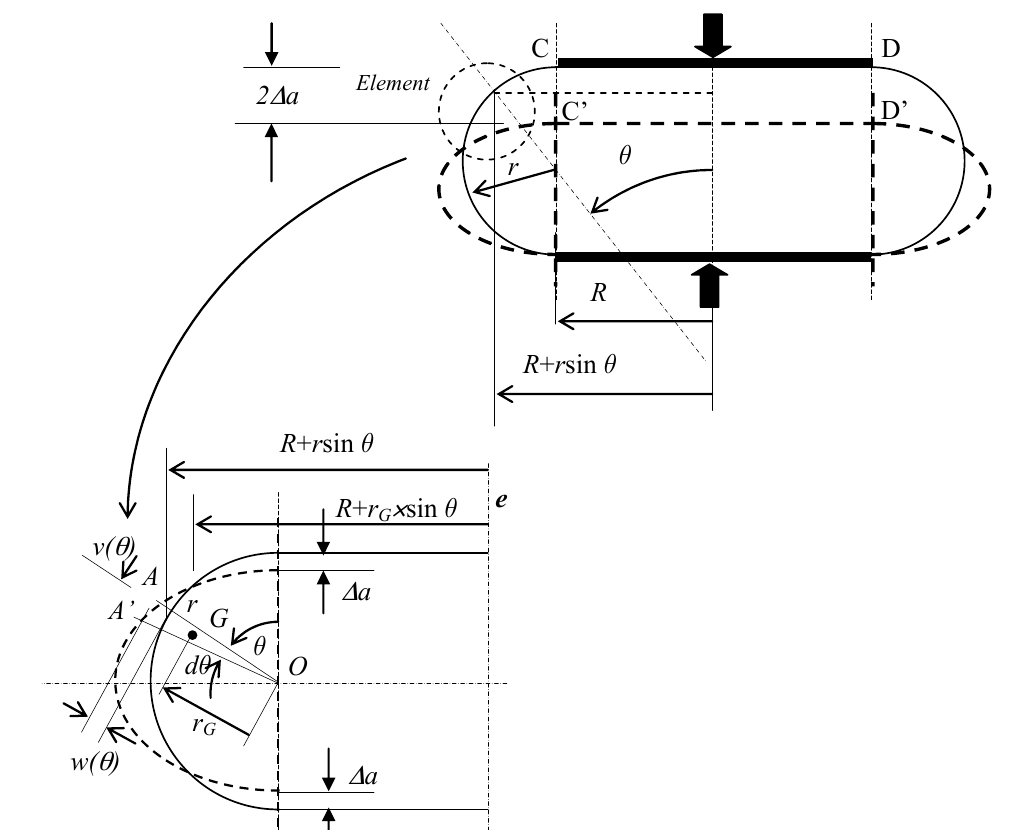
Figure 3. Axisymmetric toroidal shell element under internal pressure: displacement field by axial loads.